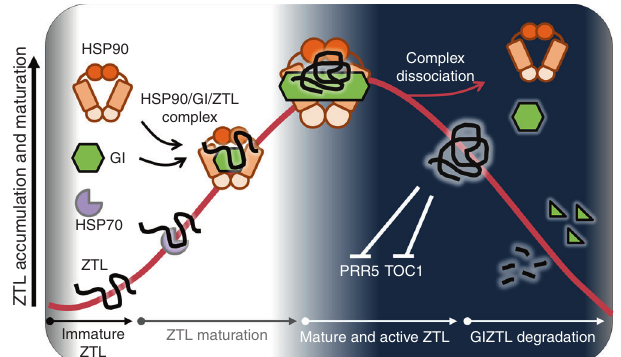
Fig. 5 Post-transcriptional oscillation of ZTL is regulated by GI and HSP90. Nascent ZTL may be fi rst captured by HSP70 in an early complex, and then transferred to a second complex comprising HSP90 and the co-chaperone GI. Order of ZTL interaction with GI and HSP90 is unknown. GI oligomerization and ZTL interaction is enhanced in the light, which may increase the binding capacity with ZTL and HSP90. Matured/active ZTL dissociates from the complex, to form SCF ZTL which ubiquitylates PRR5 and TOC1. During the dark period ZTL is degraded together with